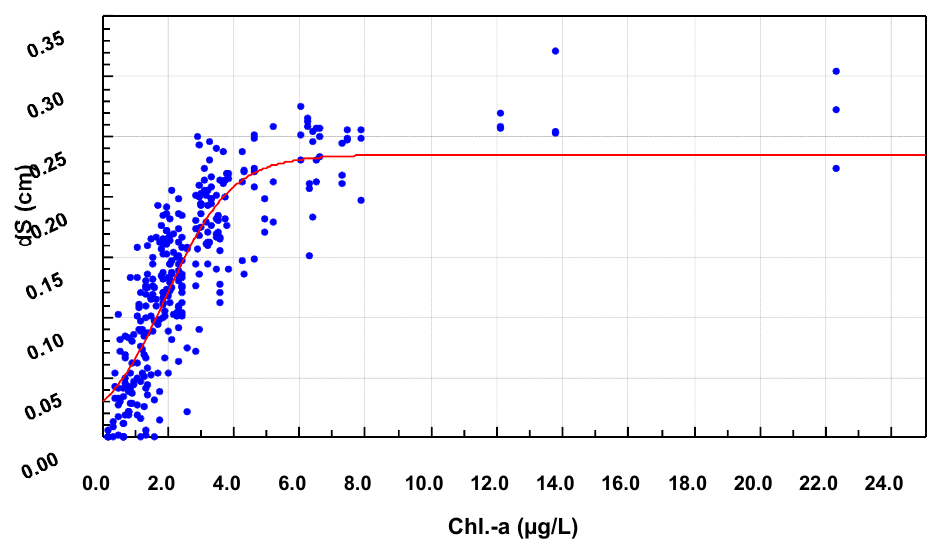
Figure 6. Identification of the Chl. a threshold beyond which growth saturation is observed.